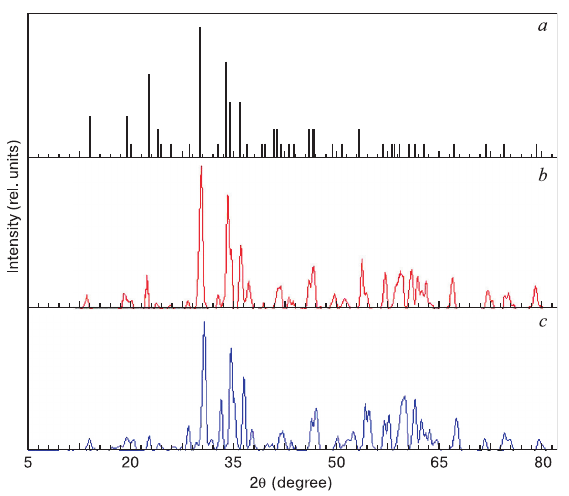
Figure 1. ( a ) Bar chart and experimental X-ray diffraction pat - terns of ( b ) pure CaGa